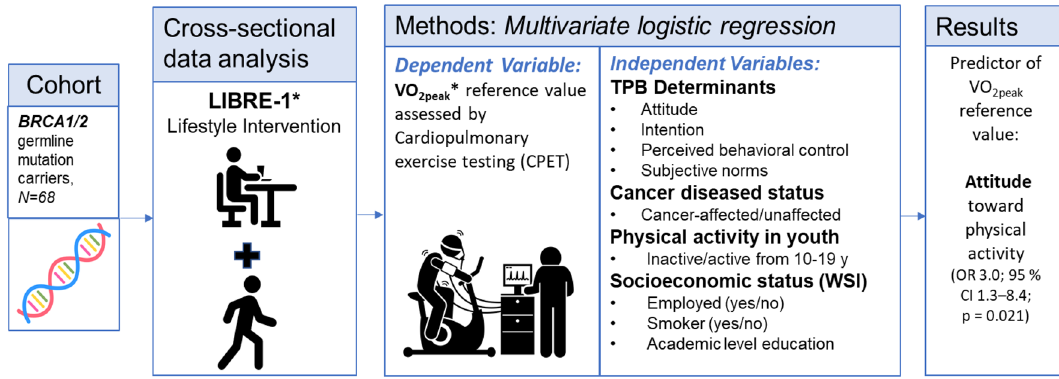
Figure 1. Graphical abstract of the analysis. * LIBRE-1 Lifestyle Intervention study in women with hereditary BREast and ovarian Cancer, 1 = pilot; RCT randomized controlled trial; TPB theory of planned behavior, WSI Winkler-Stolzenberg-Index; * VO 2peak reference values of the maximal oxygen uptake, OR odds ratio, CI confidence interval; y years. Pictures: miri019/shutterstock.com;